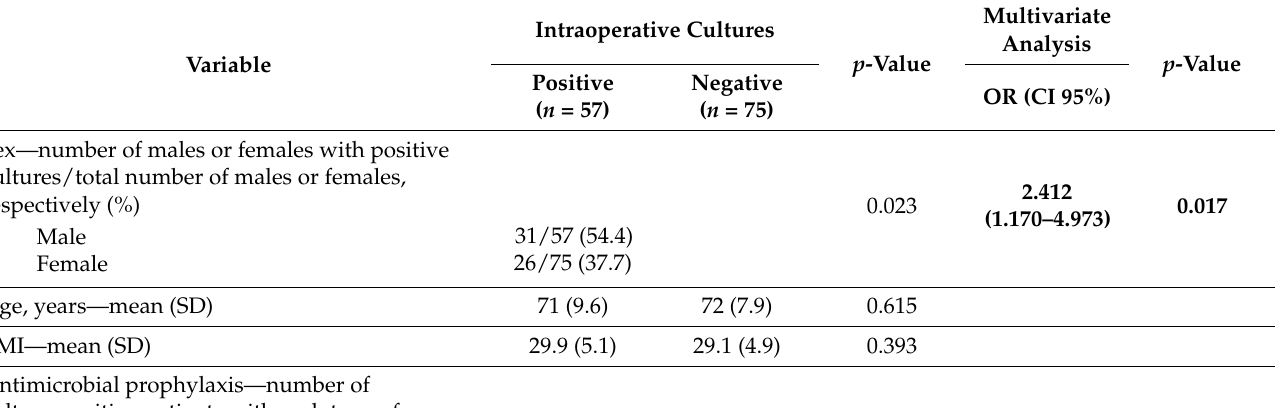
Table 1. Patients undergoing primary total knee and hip arthroplasty surgical procedures, with and without positive intraoperative